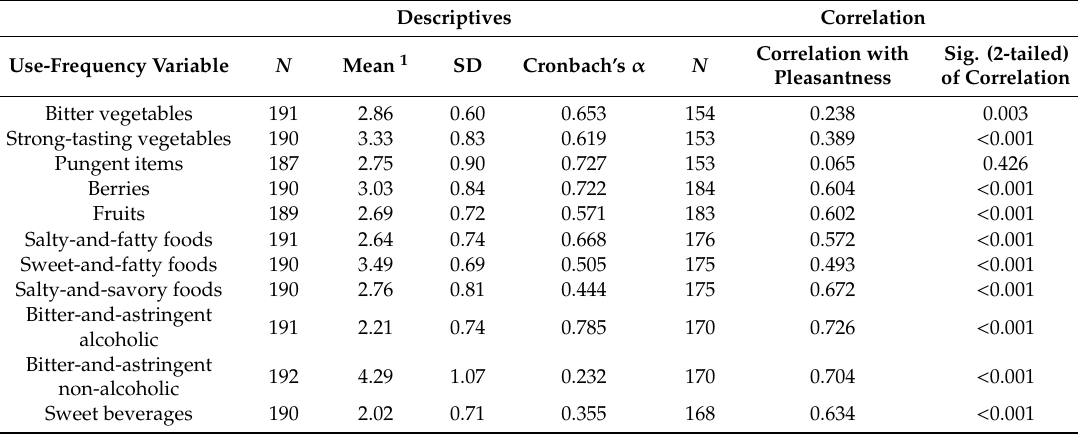
Table 6. The descriptives of use-frequency components and their correlation with equivalent pleasantness